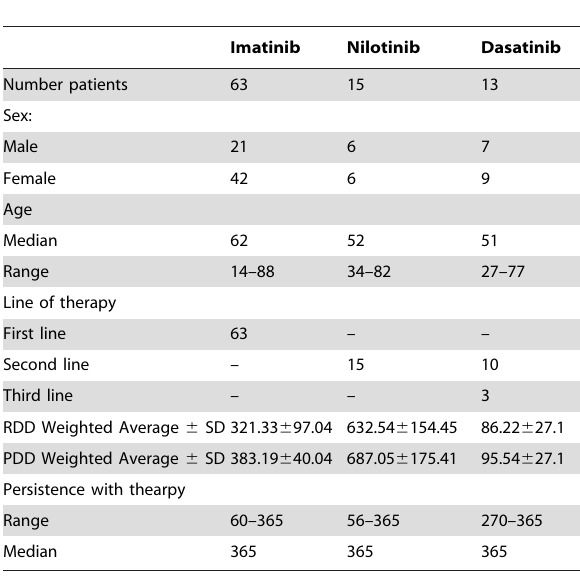
Table 1. Number of patients, sex, age and drug used parameters for Imatinib, Nilotinib,